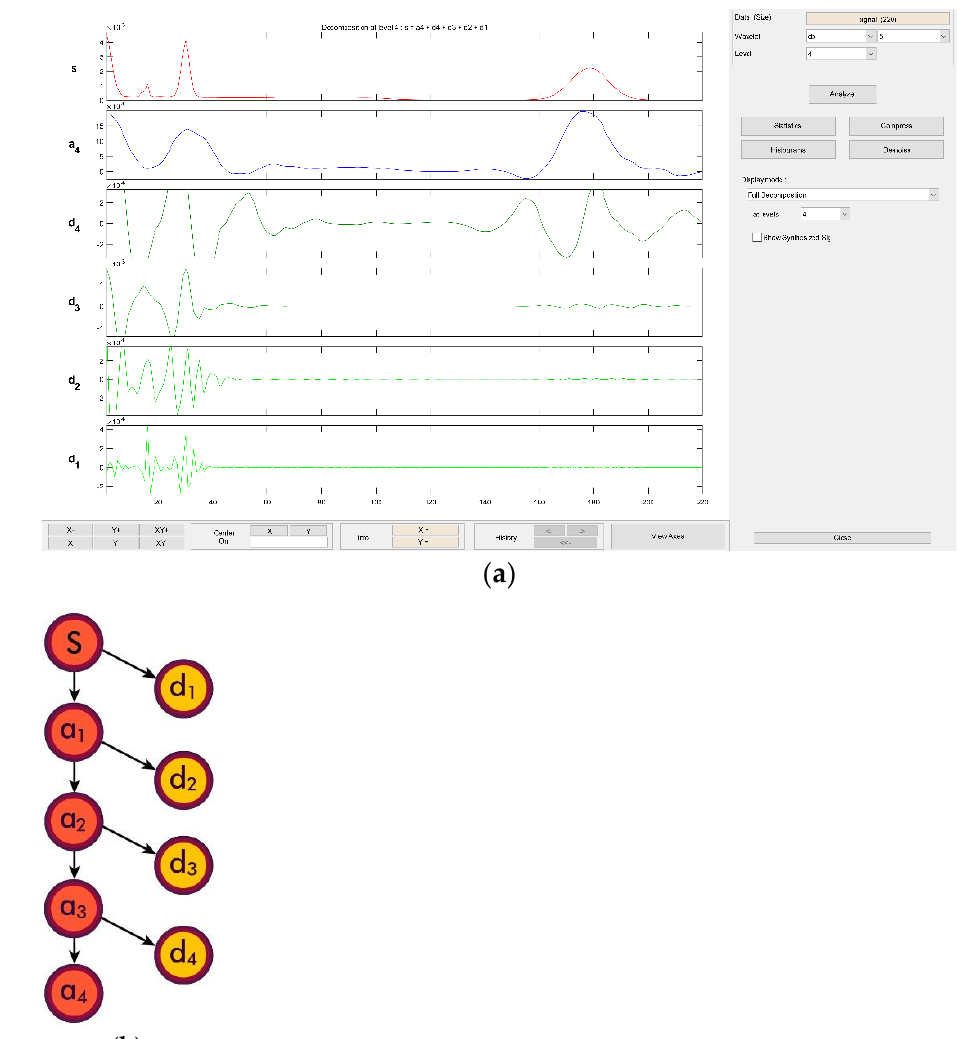
Figure 3. ( a ) Decomposed signal into approximation and details by wavelet transform, ( b ) wavelet transform tree. From each simulation, five characteristics with the names of the mean value of a 4 , d 4 , d 3 , d 2 , and d 1 were extracted, in total; a matrix of 5 × 252 was extracted for neural network training.